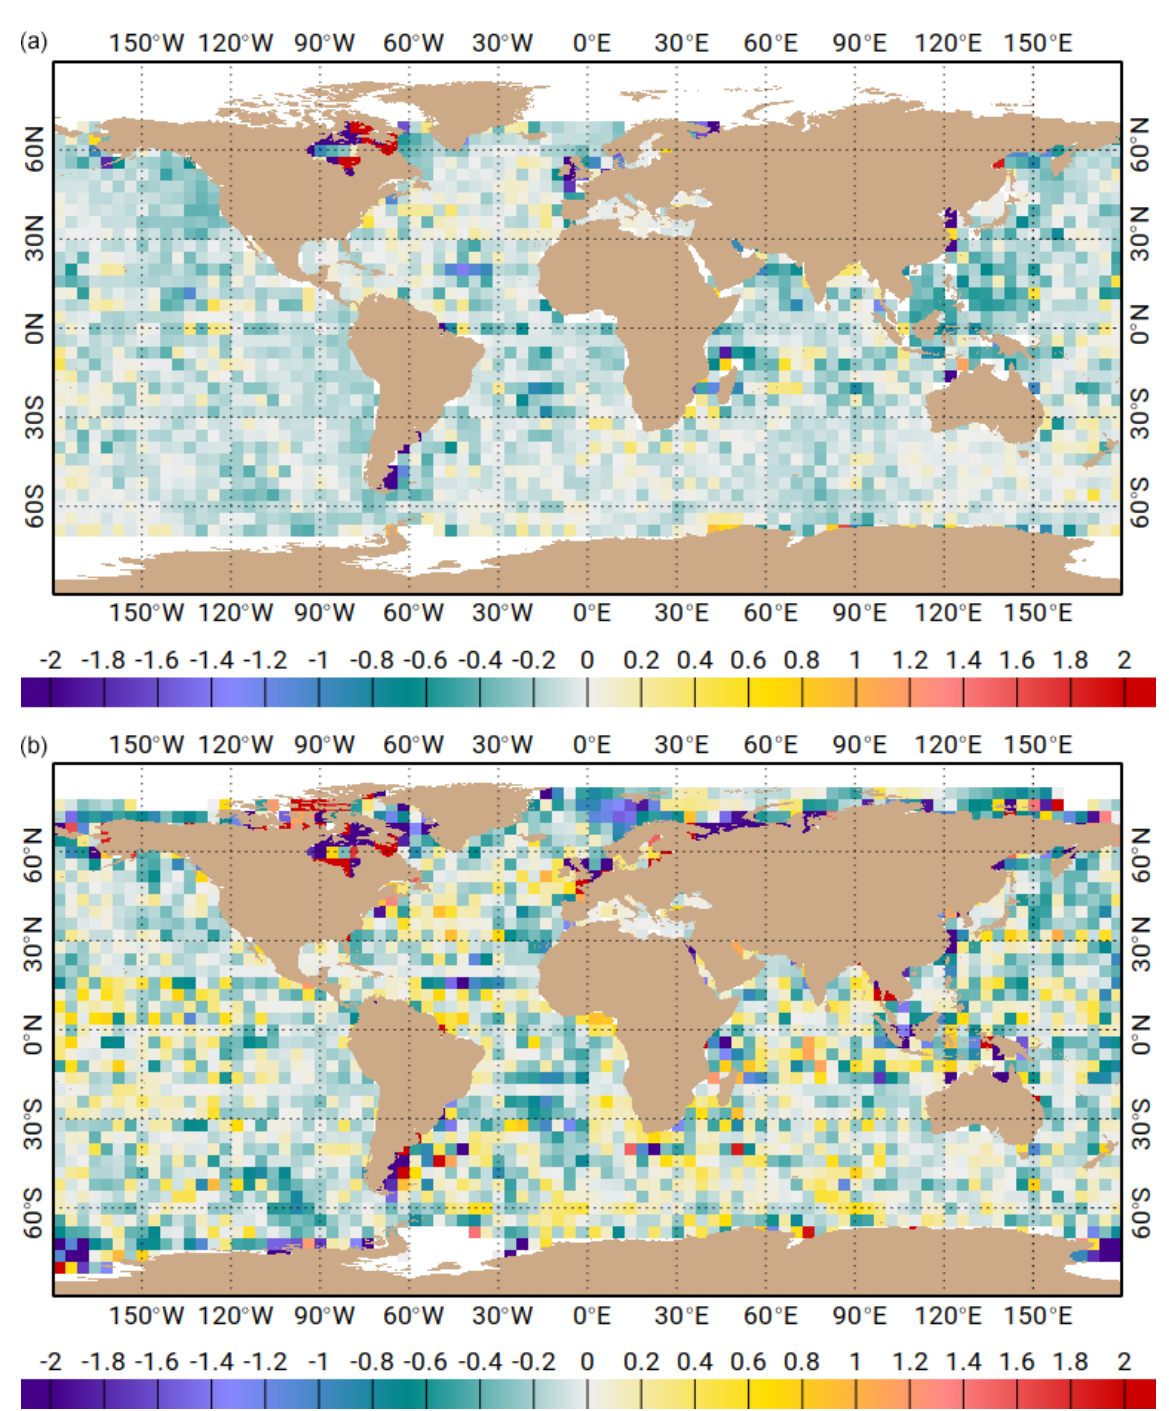
Figure 22. Maps of SSH variance differences at crossovers using the new FES2014b tidal model versus the preliminary FES2014a solution for the Jason-2 mission (a) and for AltiKa (b) (cm 2 ) . To ensure the best consistency in the ocean and load tide correction (i.e. using the load tide identical to the one used to process the assimilated data), the FES2014b ocean tide is associated with the FES2014a tidal loading, while the FES2014a ocean tide is associated with the GOT4v8ac tidal loading. Blue colours indicate a higher variance reduction when using the FES2014b tidal